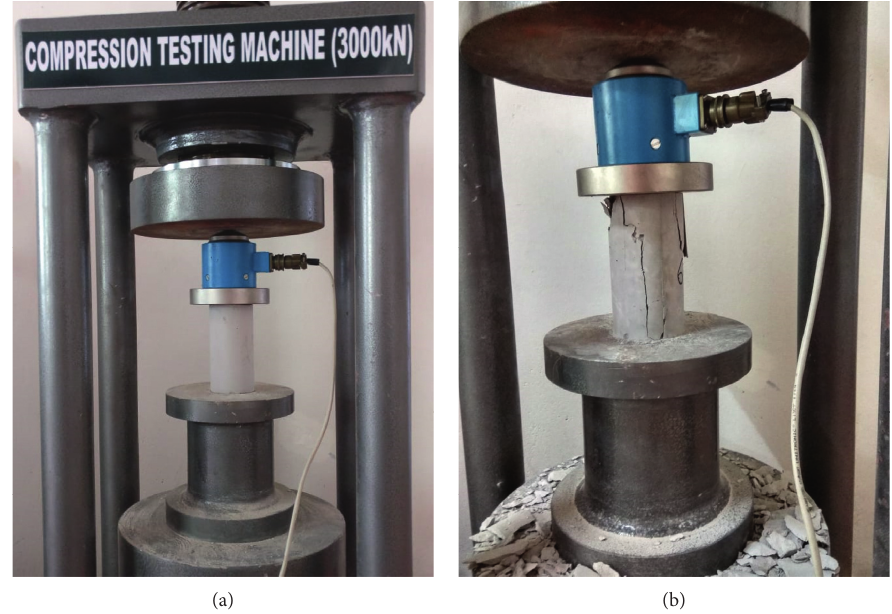
Figure 3: Compression test on geopolymer mortar cylinder: test setup (a) and typical failure mode